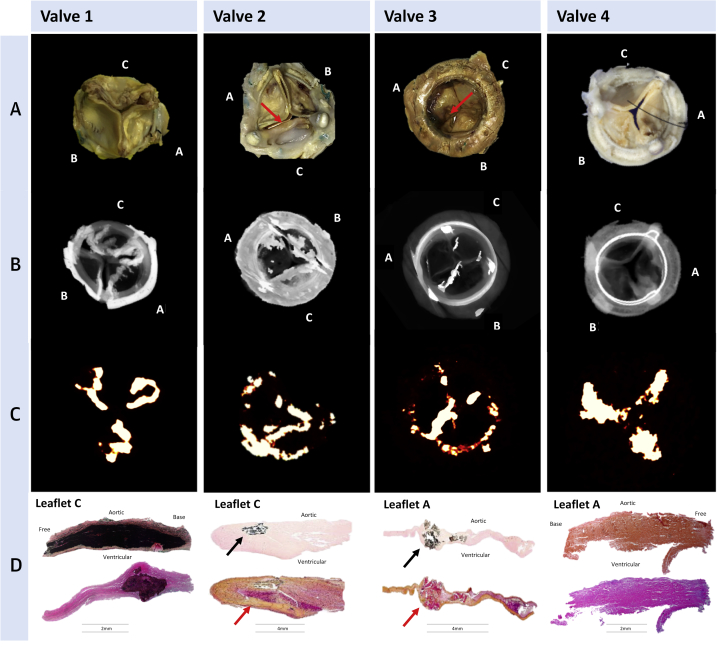
Ex Vivo Degenerated Bioprosthetic Aortic Valves: Macroscopic Appearances, Micro-CT, Micro-PET, and Histology(Row A) Macroscopic visual appearances of failed and explanted bioprosthetic valves. (Row B) CT en face images of the valves. (Row C) PET en face images demonstrating increased 18F-fluoride uptake in all valves. (Row D) Histology staining of sections taken from valve leaflet as indicated, with von Kossa (top row, calcium appears black), Movat Pentachrome (bottom row, valves 1 and 4), and hematoxylin and eosin (bottom row, valves 2 and 3) stains. All 4 degenerate bioprostheses demonstrate increased 18F-fluoride uptake in the valve leaflets. In valve 1, this uptake corresponds to gross leaflet calcification observed macroscopically and on CT images with confirmation on histology (extensive black staining). In valve 2, increased 18F-fluoride uptake is observed in association with fibrotic leaflet thickening and pannus (red arrows) with associated calcification (black arrows) observed macroscopically and on CT with confirmation on histology. In valve 3, increased 18F-fluoride uptake is observed at the site of valve leaflet thrombus (red arrow) observed macroscopically at the base of leaflet 1, with confirmation of thrombus (red arrow) and colocalized calcification (black arrow) on histology. In valve 4, extensive 18F-fluoride uptake is observed in the absence of calcification on CT and histology but instead in areas of leaflet thickening, marked fluid insudation, and disrupted collagen architecture. CT = computed tomography; PET = positron emission tomography.